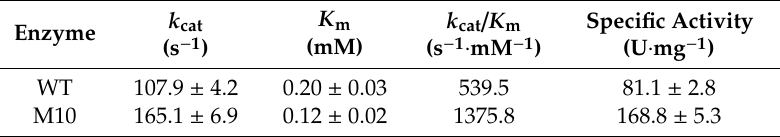
Table 1. Specific activity and kinetic parameters of WT Pt NHase and its M10